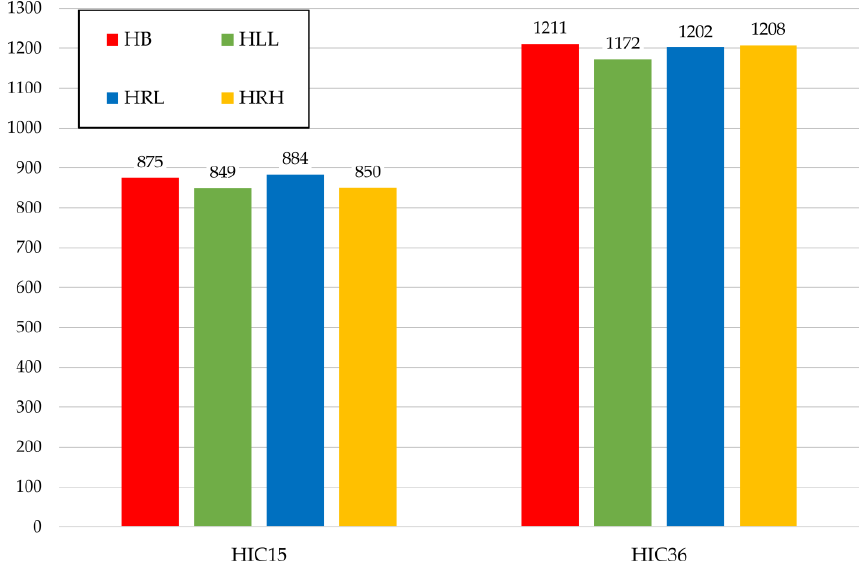
Figure 18. Head Injury Criterion (HIC) comparison.